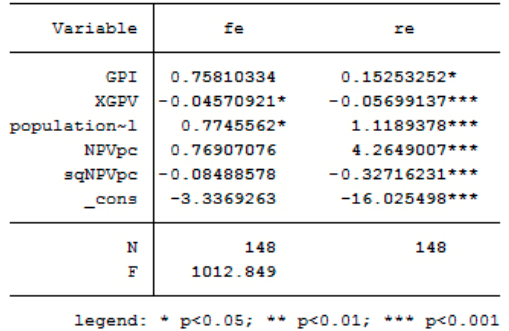
Figure 5. Comparison of FE and RE models for CO 2 emissions. Source: Own calculations according to FAOstat data [27].